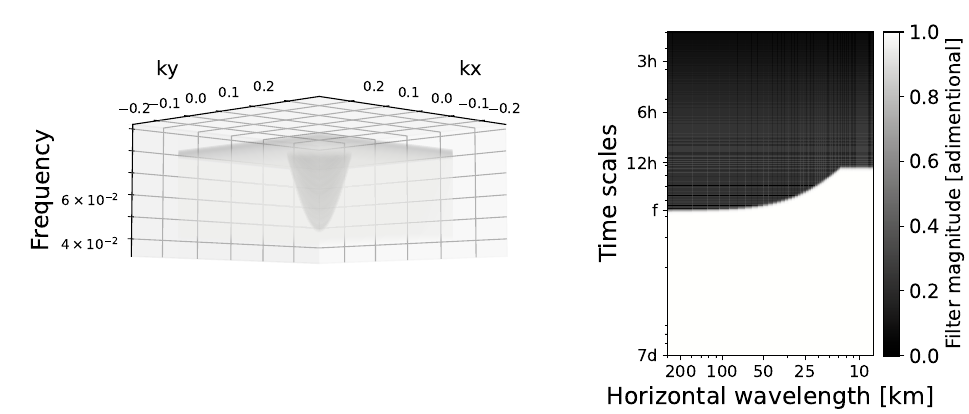
Figure 3. Dynamical filter in the k - l - ω space ( left panel ) and in the ω - k h space ( right panel ). Internal gravity waves (balanced motions) are located inside (outside) the cone shape in the left panel and in the black (white) region in the right